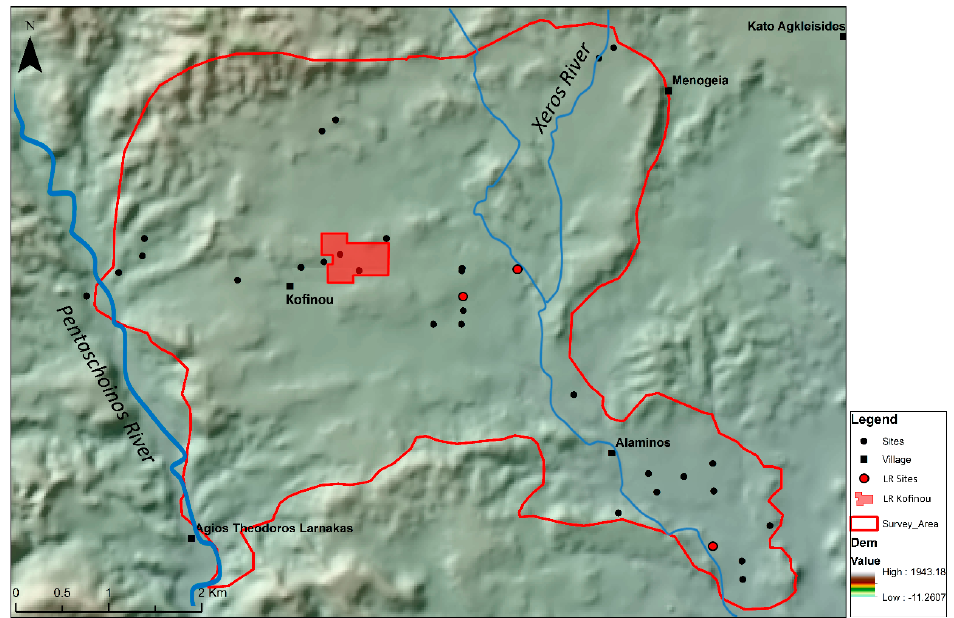
Figure 8. Late Antique (LR) sites in the Xeros valley. Image© SeSaLaC (digital geological data courtesy of the Geological Survey Department, Republic of Cyprus; GIS mapping by N. Kyriakou).